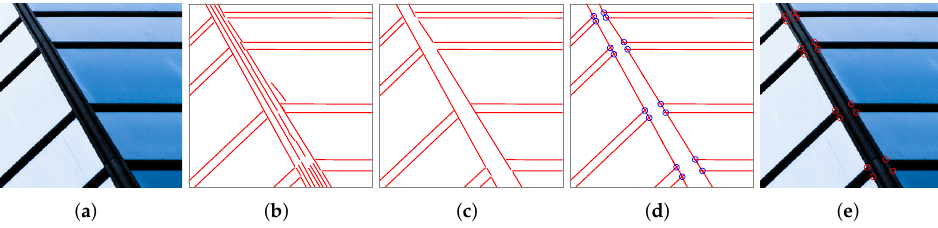
Figure 2. An example for labeling ground truth. ( a ) The original image. ( b ) The result of line segment detection. ( c ) Manually approved line segments. ( d ) The intersections of of line segments. ( e ) Corner